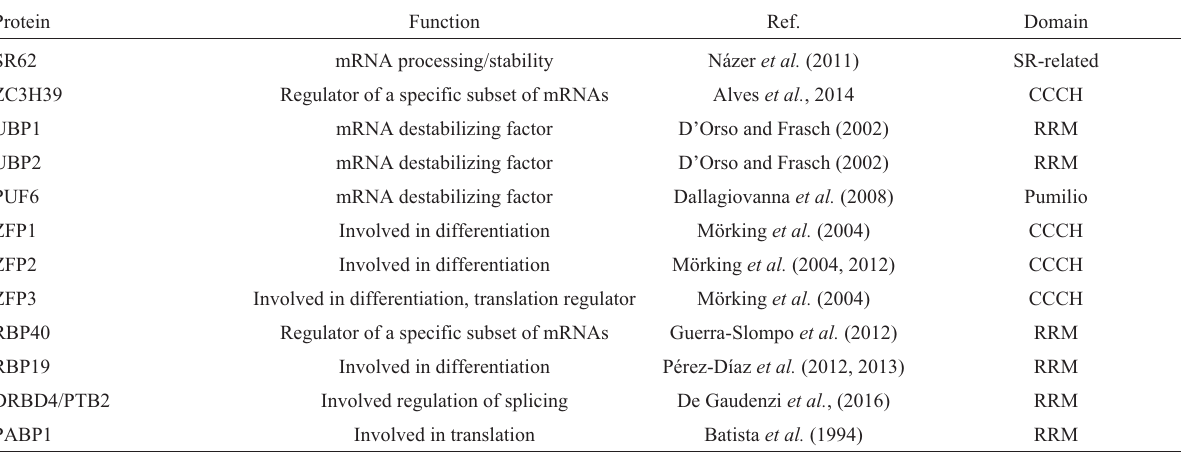
Table 1 - RNA binding proteins characterized in Trypanosoma cruzi